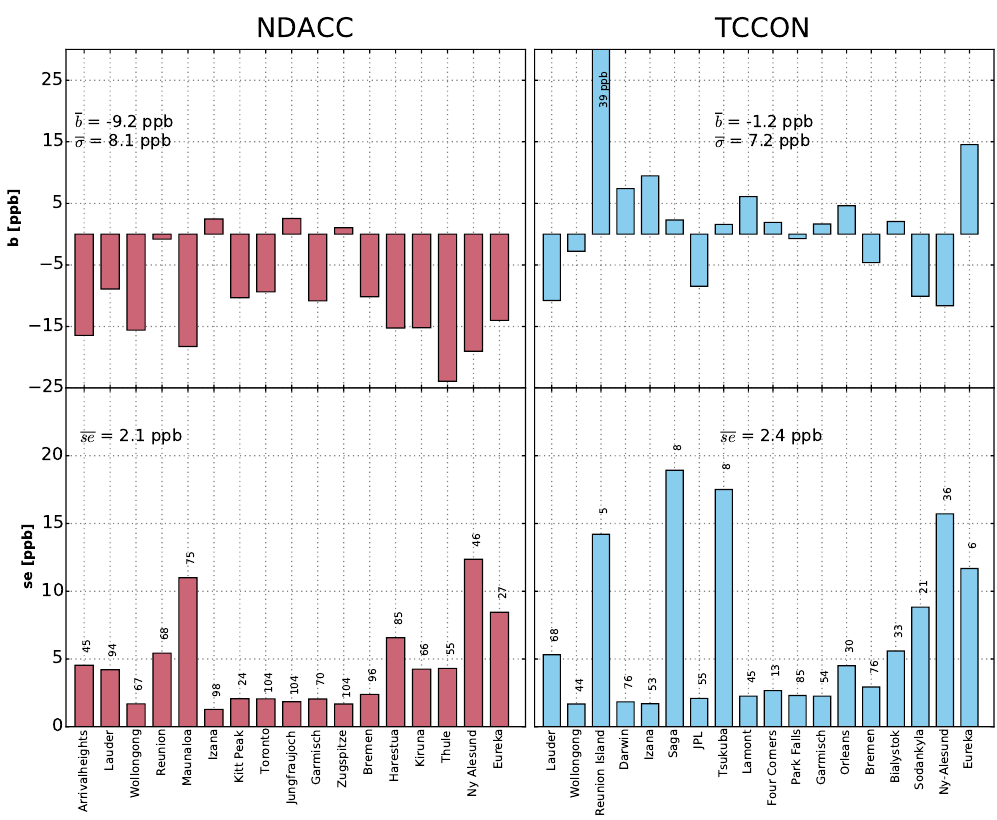
Figure 8. Mean bias (SCIAMACHY–FTS) between measurements of NDACC-IRWG (left panel) and TCCON (right panel) stations with collocated SCIAMACHY CO retrievals and the standard error of the mean bias derived from the 30day median values shown in Figs. 6 and 7 (numbers of 30-day medians are indicated above bars). The ¯ b is the global mean bias (average of all station biases weighted by the standard error) and ¯ σ its standard deviation. ˆ se is the average of all standard